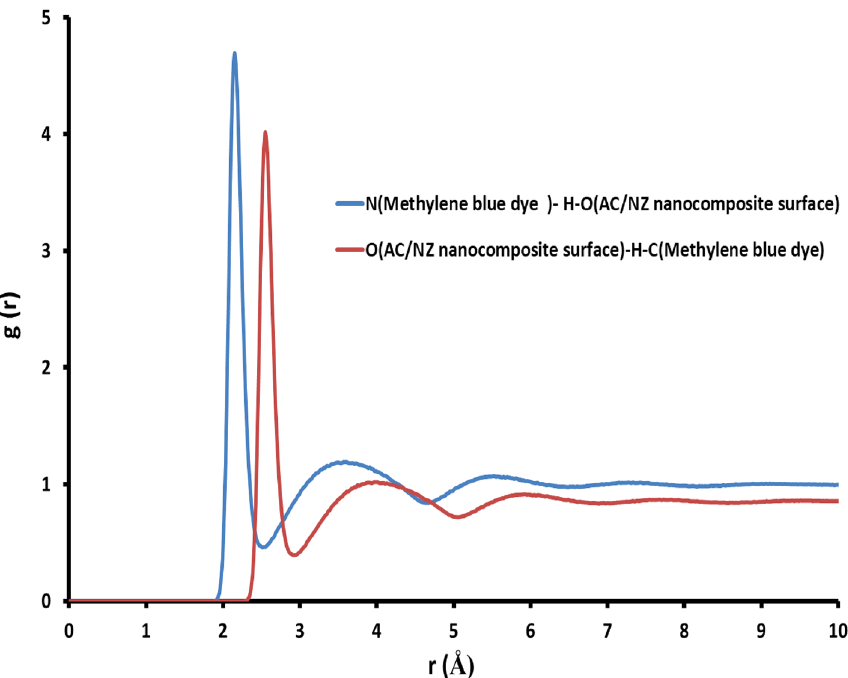
Figure 12. The RDFs for the interaction sites of MB dye with the AC/NZ nanocomposite surface atoms in the presence of water at 5